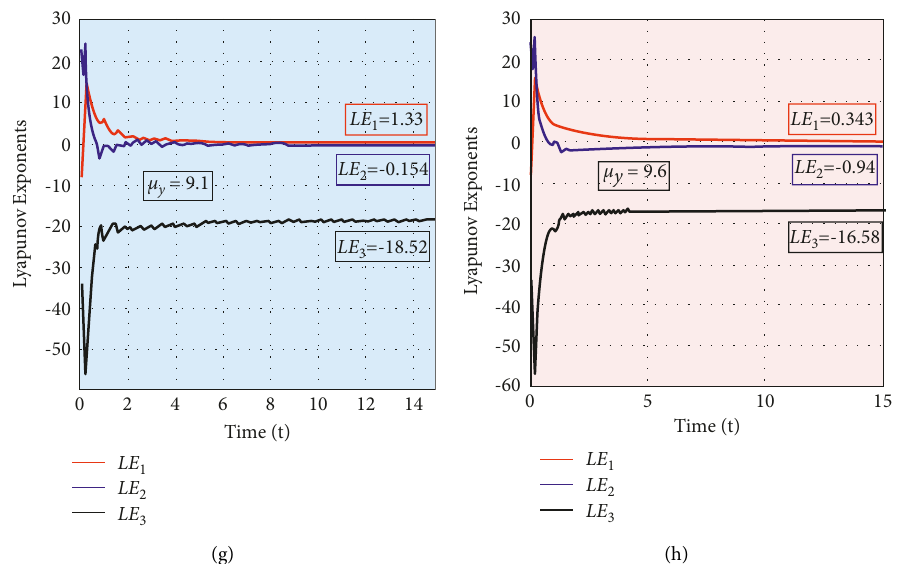
Figure 7: Lyapunov exponents corresponding to each subregion in Figure